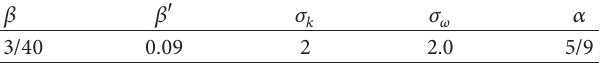
Table 3: Constants for the low-Reynolds 𝑘 - 𝜔 turbulence